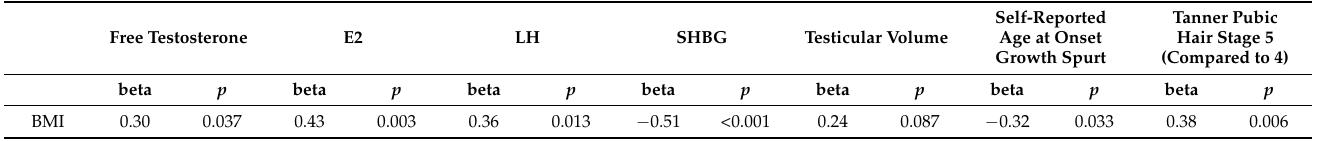
Table 5. Univariate linear regression between body mass index (BMI) and reproductive hormones and pubertal characteristics in